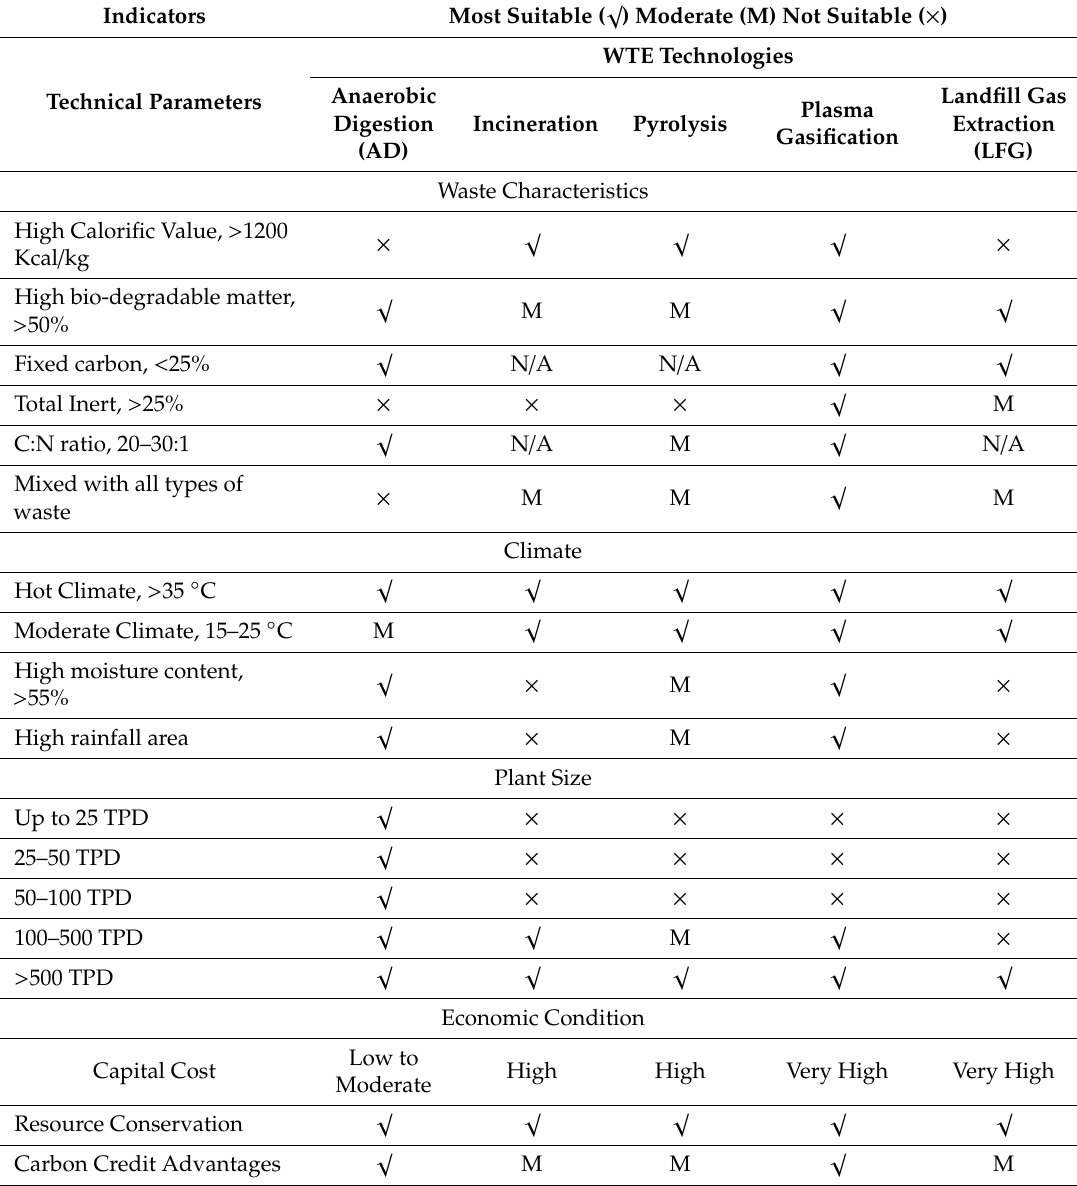
Table 11. The technical parameter indicative chart for various MSW-to-Energy projects